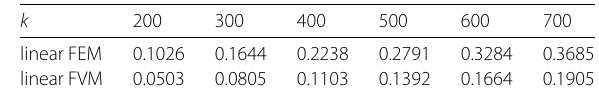
Table 8 The error in the relative discrete H 1 -seminorm for problem (5.1) with kh =